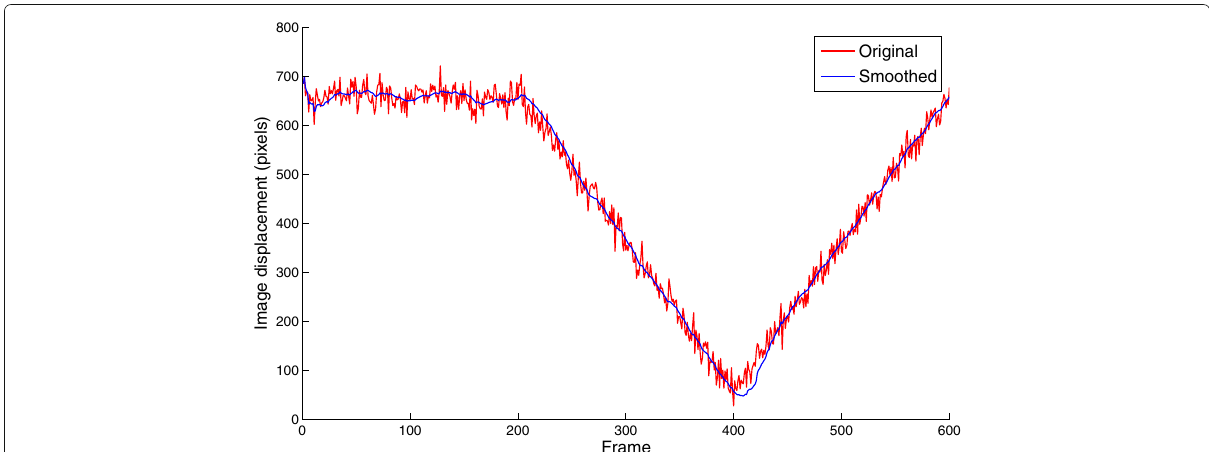
Fig. 3 Synthetic simulation: original and smoothed motion using the proposed approach